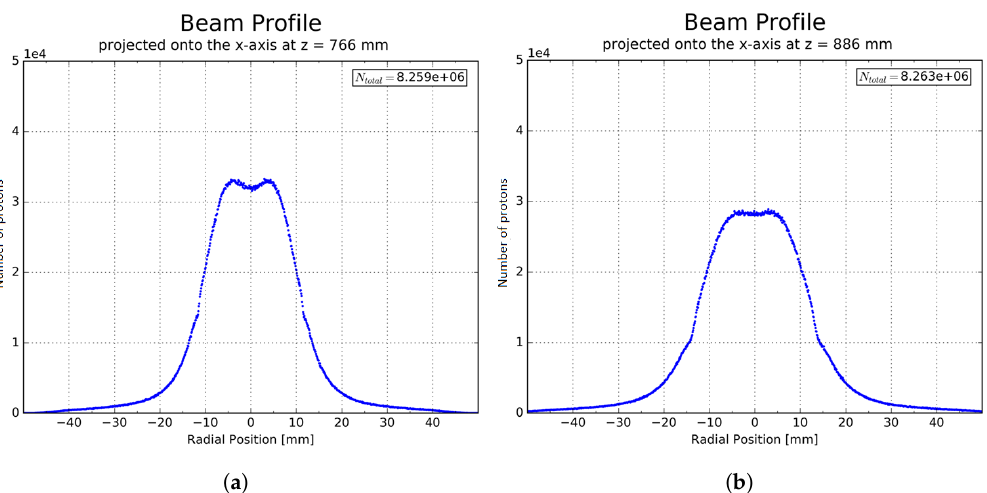
Figure 10. ( a ) Lateral profile of the proton beam at z = 766 mm with the Si-disc at position z = 766 mm; and ( b ) lateral profile of the proton beam at z = 886 mm with the Si-disc at z = 886 mm. The profiles show a bigger spread of the protons with the Si-disc. However, the FWHM relevant for the clinical treatment remains the same. Table 3. Energy at iso-center for dedicated position of VELO modules. The Energy without the modules is 60.25